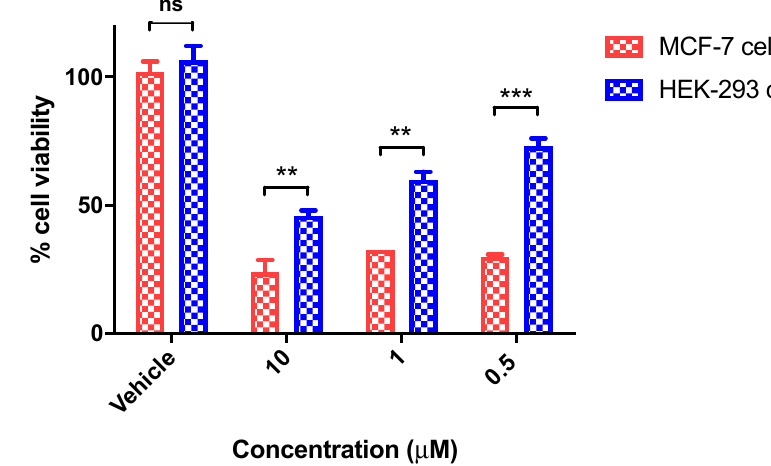
Figure 4. Effect of compound 10n on the viability of MCF-7 cells and non-tumorigenic HEK-293T cells. Cells were grown in 96-well plates and treated with compound 10n at 0.5, 1 and 10 µ M for 72 h. Cell viability was expressed as a percentage of vehicle control (ethanol 1% ( v/v )) treated cells and was measured using an AlamarBlue assay (average of three independent experiments). Two-Way ANOVA (Bonferroni post-test) was used to test for statistical significance (**, p < 0.05, ***, p <